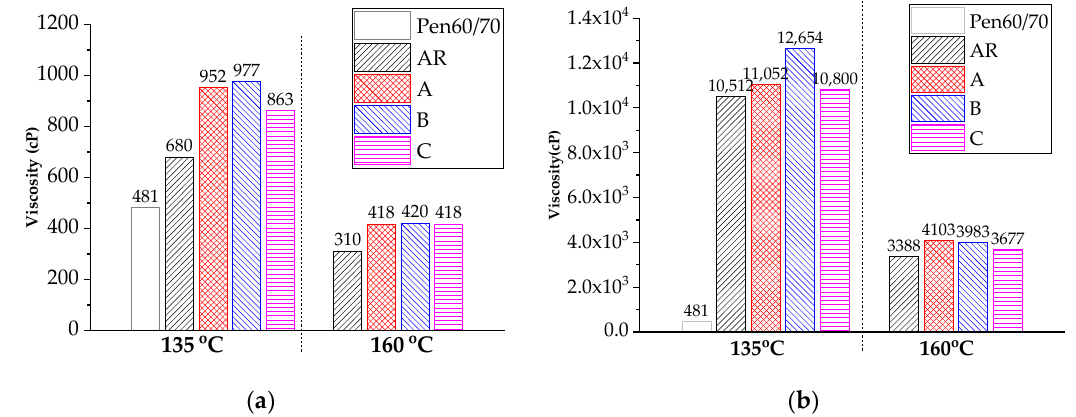
Figure 4. Rotational viscosity of asphalt binders: ( a ) Bitumen with 10 wt. % CRM; ( b ) Bitumen with 20 wt. % CRM.